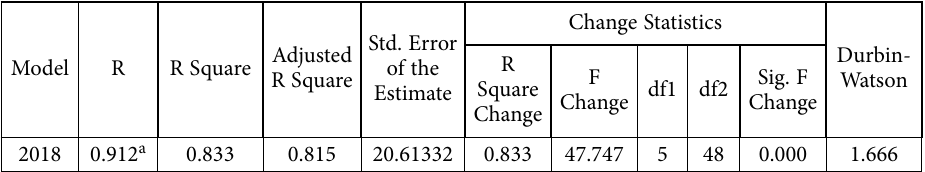
Std. Error Adjusted of R Square